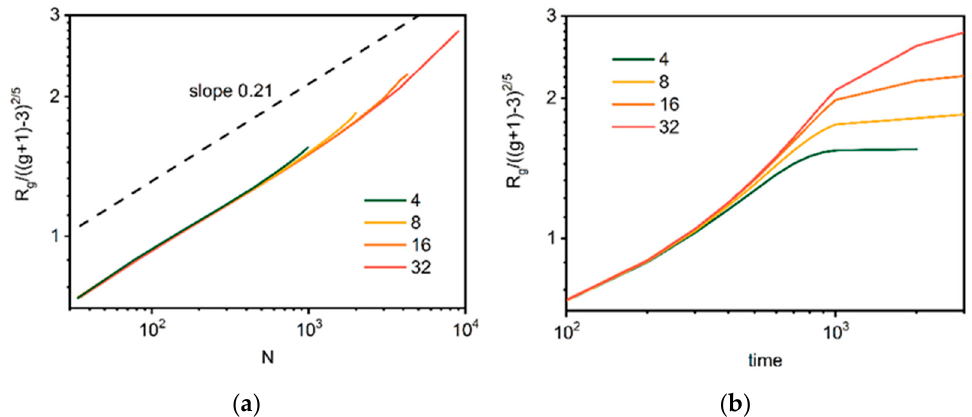
Figure 12. The reduced radius of gyration for dendrimers R g /(( g + 1) − 3) 2/5 as a function of total number of beads N ( a ) and time ( b ). The color indicates the number of macromolecules in the system (see text for details).